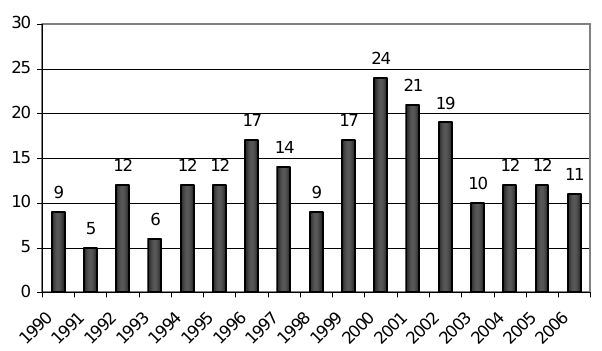
Fig. 3. Annual distribution of all the cases between 1990 and 2006. Fig. 3 . Annual distribution of all the cases between 1990 and 2006.